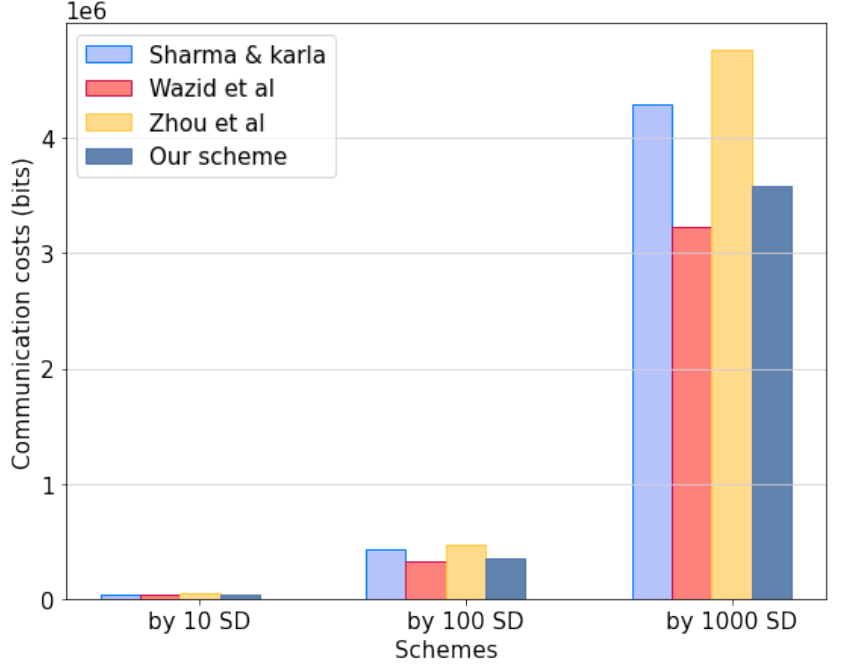
Figure 4. Communication cost comparison in sensing devices [20–22].